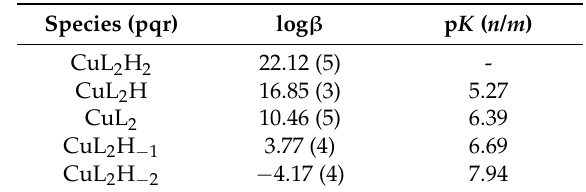
Table 3. Stability constants log β (pqr) and p K values of the complex species formed by Cu(II) with